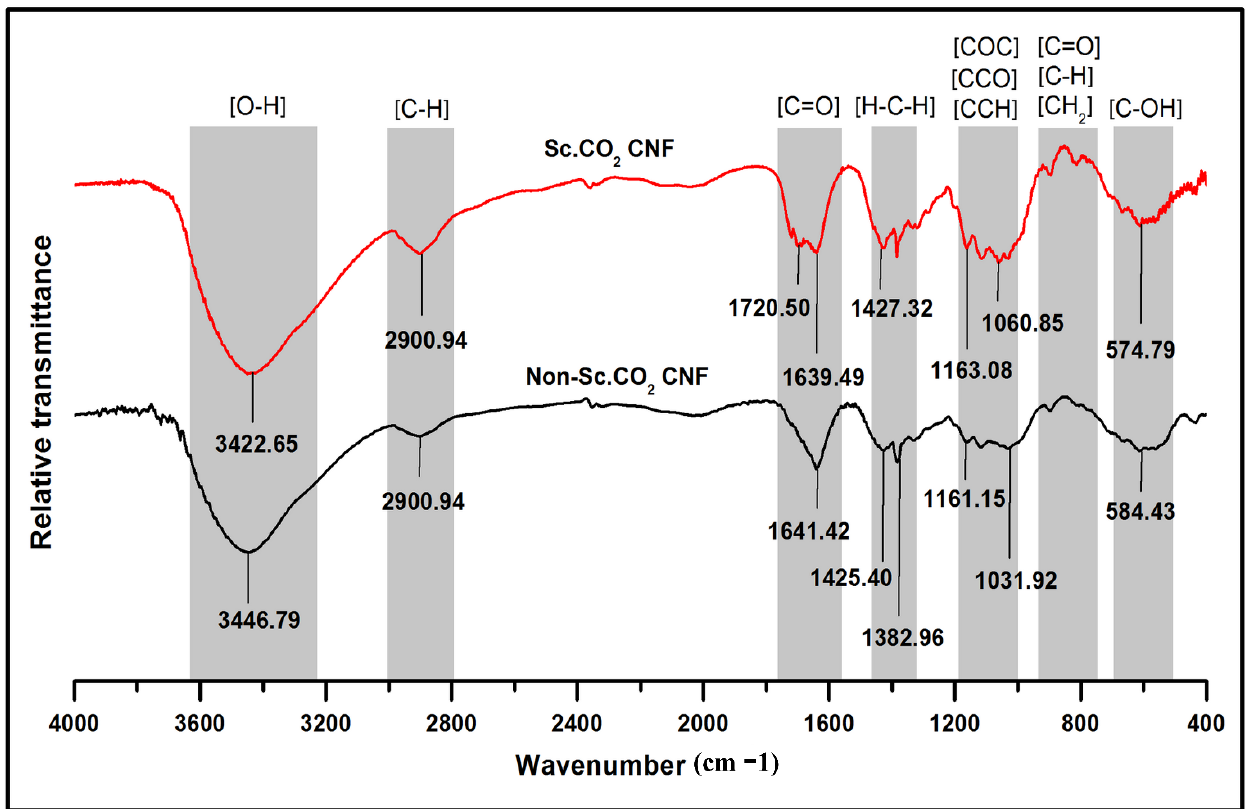
Figure 3. FT-IR spectra of Sc.CO 2 and non-Sc.CO 2 obtained CNFs.